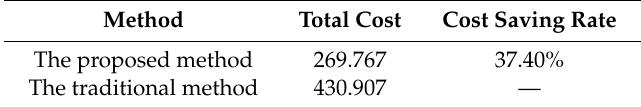
Table 7. Comparison of the proposed method with the method of traditional risk as maintenance